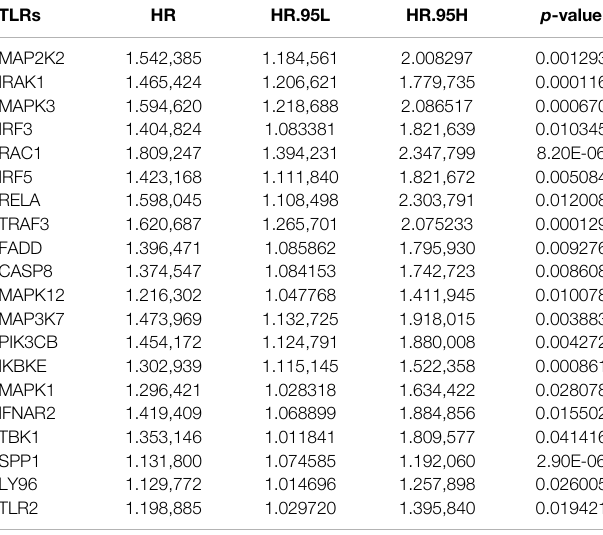
TABLE 2| UnivariateCoxregressionanalyses forprognosis-related HCC-speci fi c TLRs in the TCGA cohort.